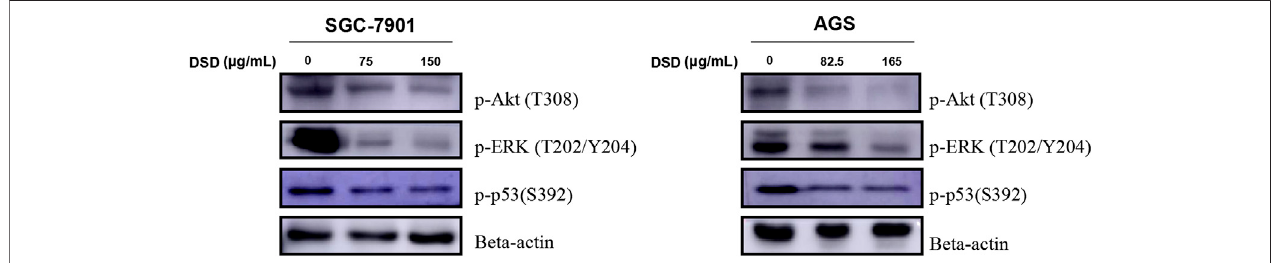
FIGURE 7| DSD treatment resulted in down-regulating the phosphorylation level ofAkt, ERK, and p53 signaling pathways. SGC-7901 (0, 75, and 150 μ g/ml) and AGS(0,82.5,and165 μ g/ml)cellsweretreatedwithDSDatdifferentconcentrationsfor24 h.Afterproteinswereextracted,theexpressionlevelsofp-Akt(T308),p-ERK (T202/Y204) and p-p53 (S392) were analyzed by Western Blot assay.